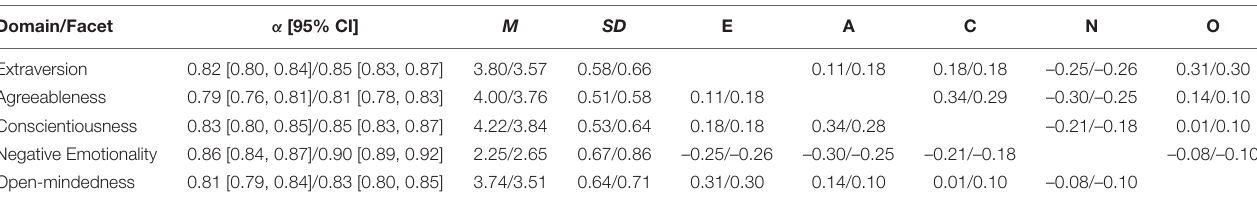
TABLE 3 | Reliability estimates (with confidence intervals) and intercorrelations for scores from BFI-2 domains (Study 1 and